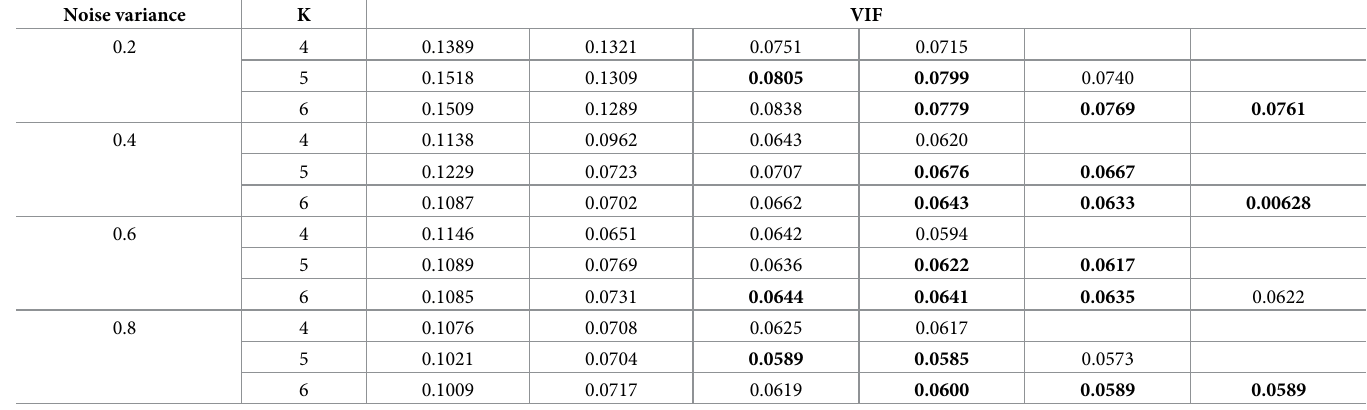
Table 1. VIF value of each sub-modal